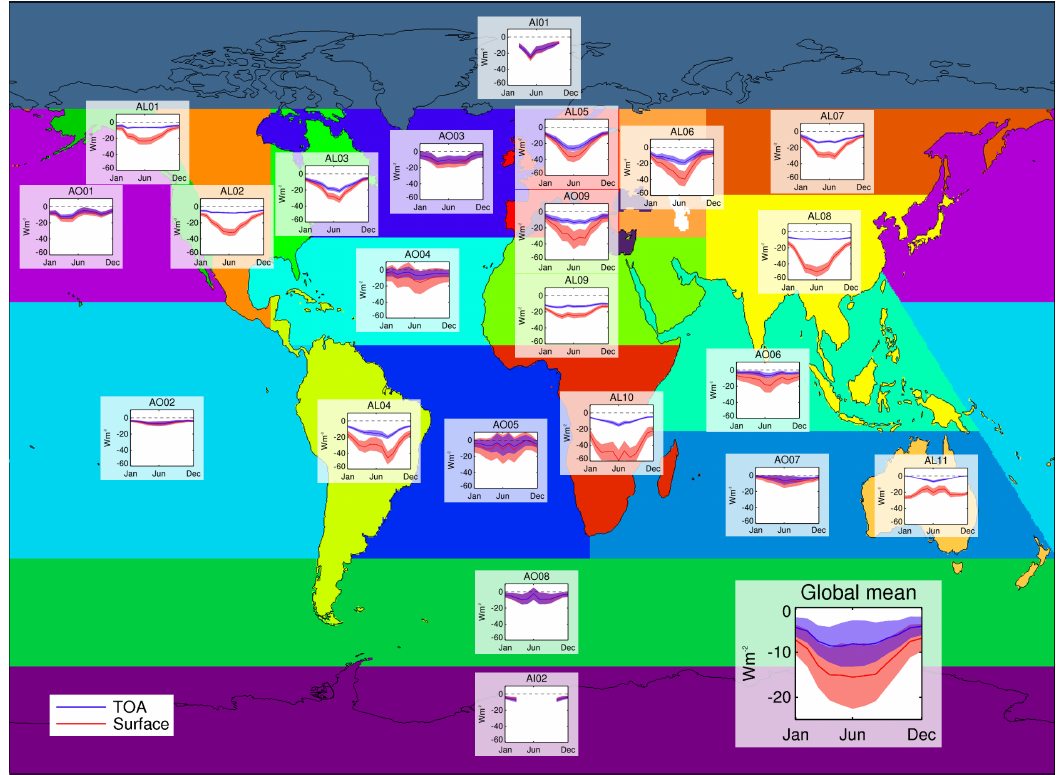
Fig. 5. Regional and monthly mean clear sky aerosol radiative effect (in Wm − 2 ) calculated after bias correcting the 2006 GlobAEROSOL aerosol optical depth retrievals compared with AERONET. The shading represents the uncertainty and the plot in the lower right corner shows the global